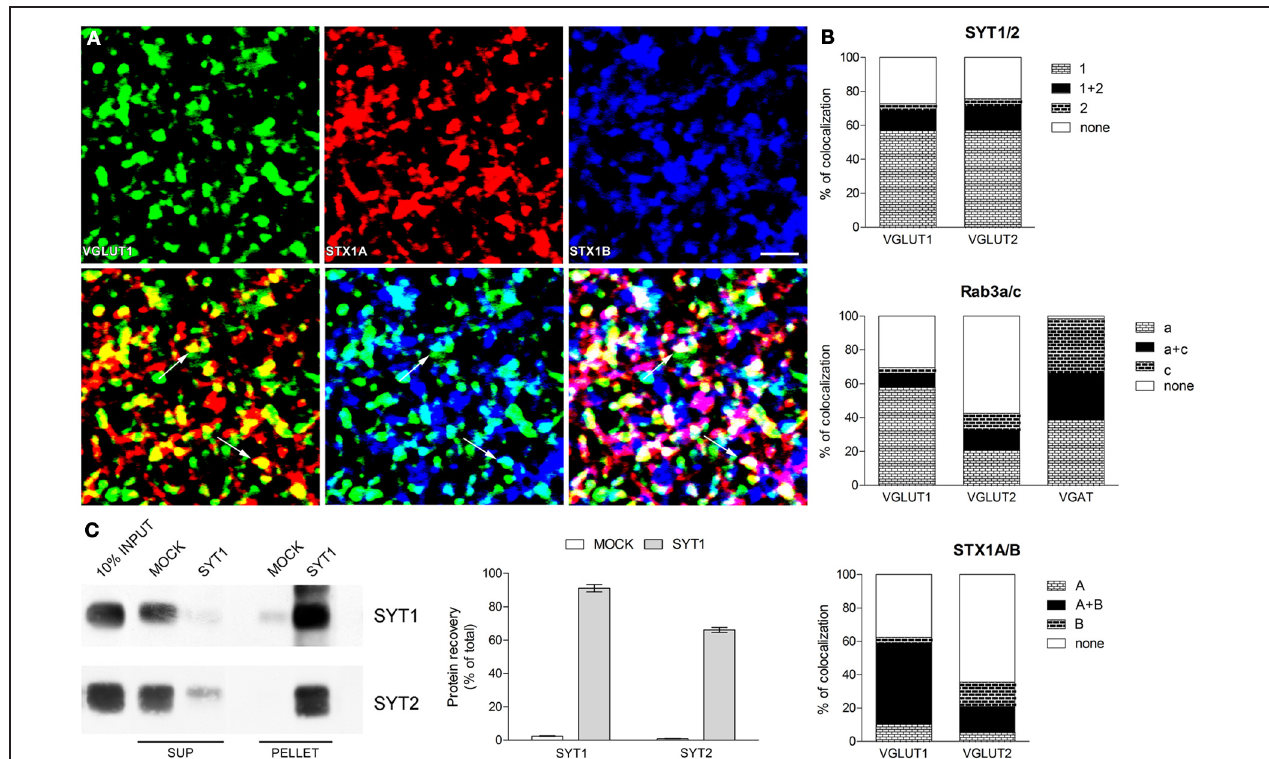
FIGURE 1 | Expression of presynaptic proteins isoforms in cerebral cortex (A) Triple labeling confocal microscopy studies. Example of triple labeling studies: green codes for VGLUT1, red for STX1A and blue for STX1B. Rat brains (2–4 for each pairs of isoforms) were perfused and post-fixed for 2h with 4% PFA (Bragina et al., 2007); vibratome sections (2–4 for each series) were processed with the same antibodies (to VGLUT1, VGLUT2, VGAT, SYT1 and 2, Rab3a and c, STX1A and B) and using the same conditions and methods described in previous studies (Bragina et al., 2007, 2010, 2012). Images were from parietal cortex and were acquired from randomly selected subfield (20–30 for each section) in layers II–VI. Each channel was examined separately to identify and manually count immunopositive puncta (first line); the two channels (green and red or green and blue) and the three channels were than merged and the number of co-localizing puncta was counted manually (second line). Following merging, puncta were considered double